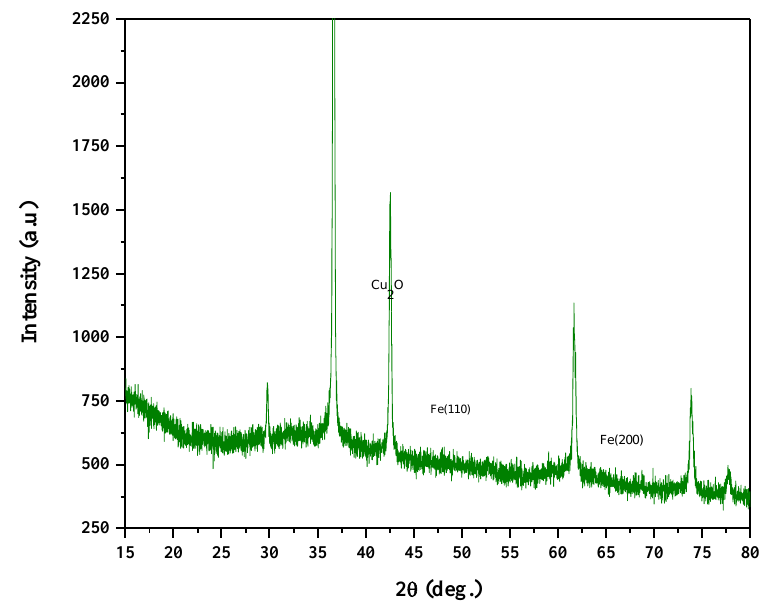
Figure 2. X-ray diffraction patterns of Fe/Cu bimetallic nanoparticles. Adopted from [83] .